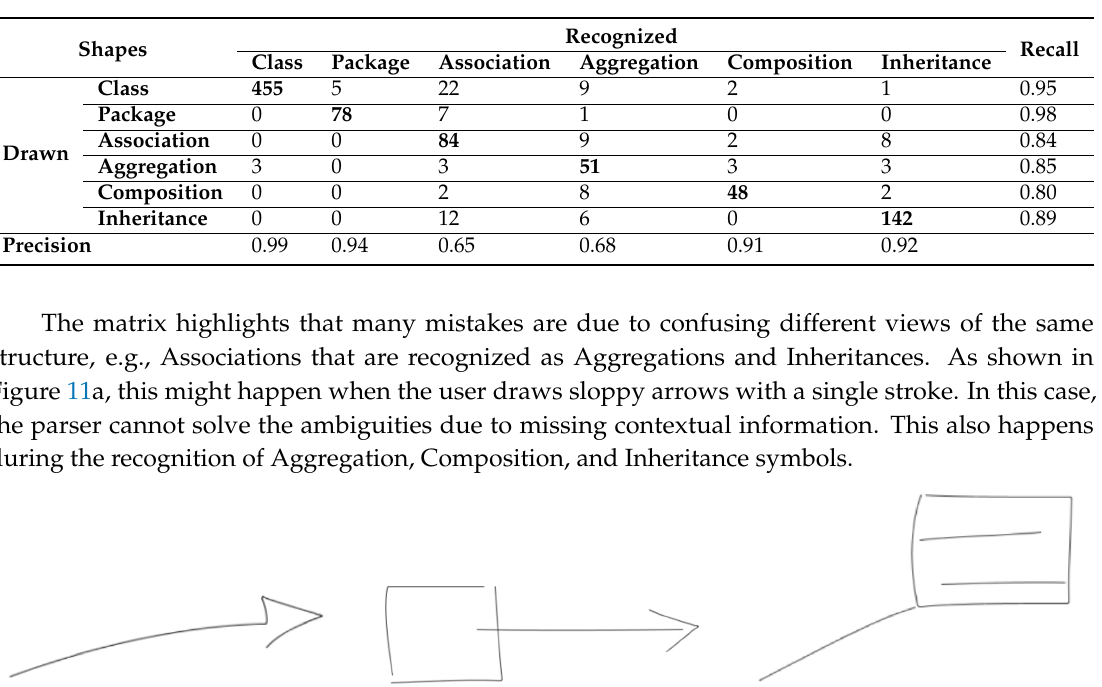
Table 2. Confusion matrix for the class diagram symbols. Each row shows the number of symbols of a given type that were assigned to each class. The last column shows the recall and the last row the precision.